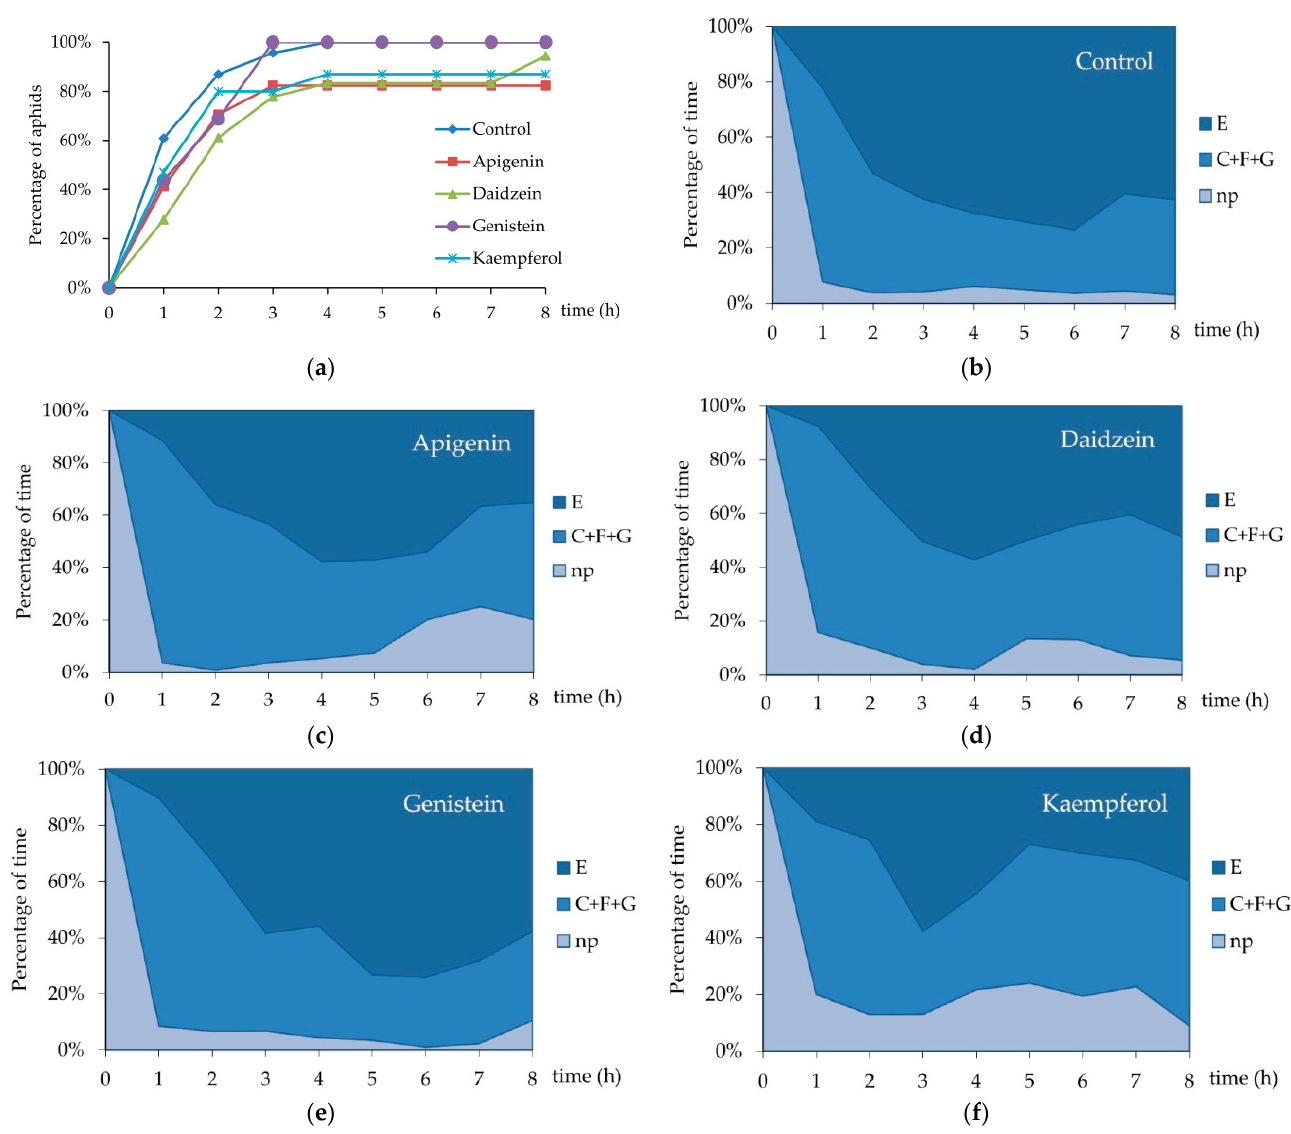
Figure 3. Sequential changes in EPG-recorded stylet penetration activities of Acyrthosiphon pisum on Pisum sativum : ( a ) Cumulative percentage of aphids that attained phloem phase during the 8 h EPG monitoring on P. sativum treated with 0.1% apigenin, daidzein, genistein and kaempferol; ( b ) sequential changes in penetration activities of A. pisum on control untreated P. sativum ; ( c ) sequential changes in penetration activities of A. pisum on P. sativum treated with 0.1% apigenin; ( d ) sequential changes in penetration activities of A. pisum on P. sativum treated with 0.1% daidzein; ( e ) sequential changes in penetration activities of A. pisum on P. sativum treated with 0.1% genistein; ( f ) sequential changes in penetration activities of A. pisum on P. sativum treated with 0.1% kaempferol. Panels ( b – f ) represent the proportion of time (average percentage of cumulative time for aphids in the group) devoted to np—non-probing, C + F + G—pathway + derailed stylet activities + xylem phase, and E—phloem phase E1 (salivation) + E2 (sap ingestion) activities of A. pisum during the consecutive hours of 8 h EPG recording (control n = 23; apigenin-treated n = 17; daidzein-treated n = 18; genistein-treated n = 16; kaempferol-treated n = 15).